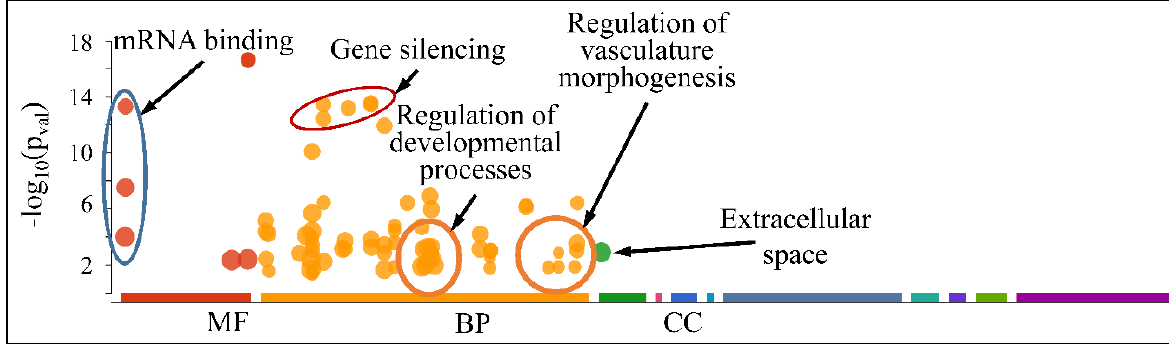
Figure 14. Functional annotation of miRNAs found globally down-regulated in all tumor samples (Legend: MF: Molecular Function, BP: Biological Process, CC: Cellular Component).